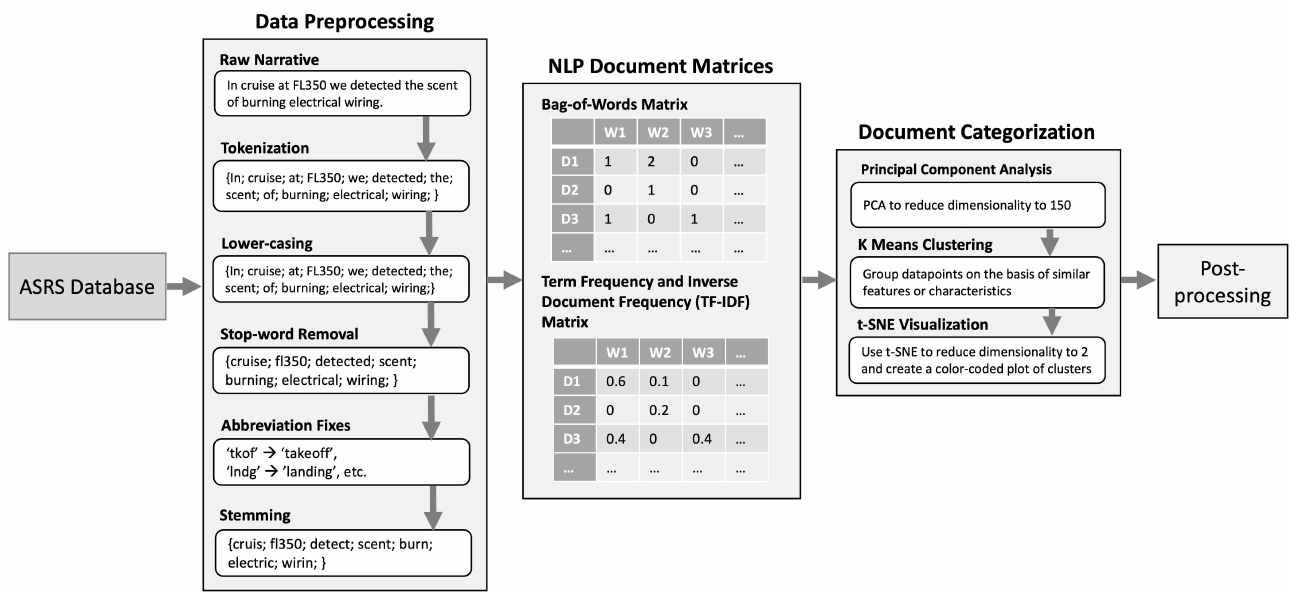
Figure 1. Methodology overview for data preprocessing, NLP implementation, and ASRS report classification leading up to post-processing (adapted from Ref.